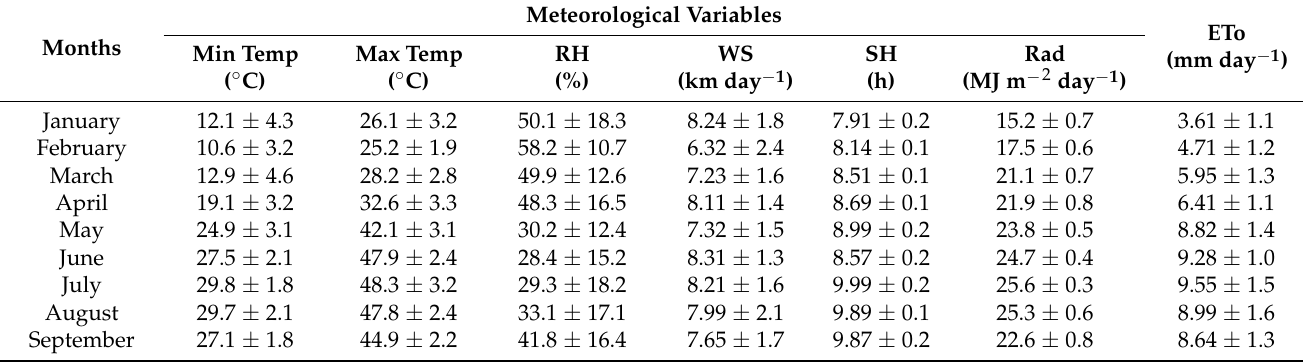
average wind speed was 9.3 km h − 1 . The highest monthly average ETo was 9.19 and 9.43 mm day − 1 during June and July, respectively. Table 2. Monthly average values ± standard deviation of minimum temperature (Min Temp), maximum temperature (Max Temp), relative humidity (RH), wind speed (WS), sun hours (SH), solar radiation (Rad), and reference evapotranspiration (ETo) during the 2020–2021 seasons.